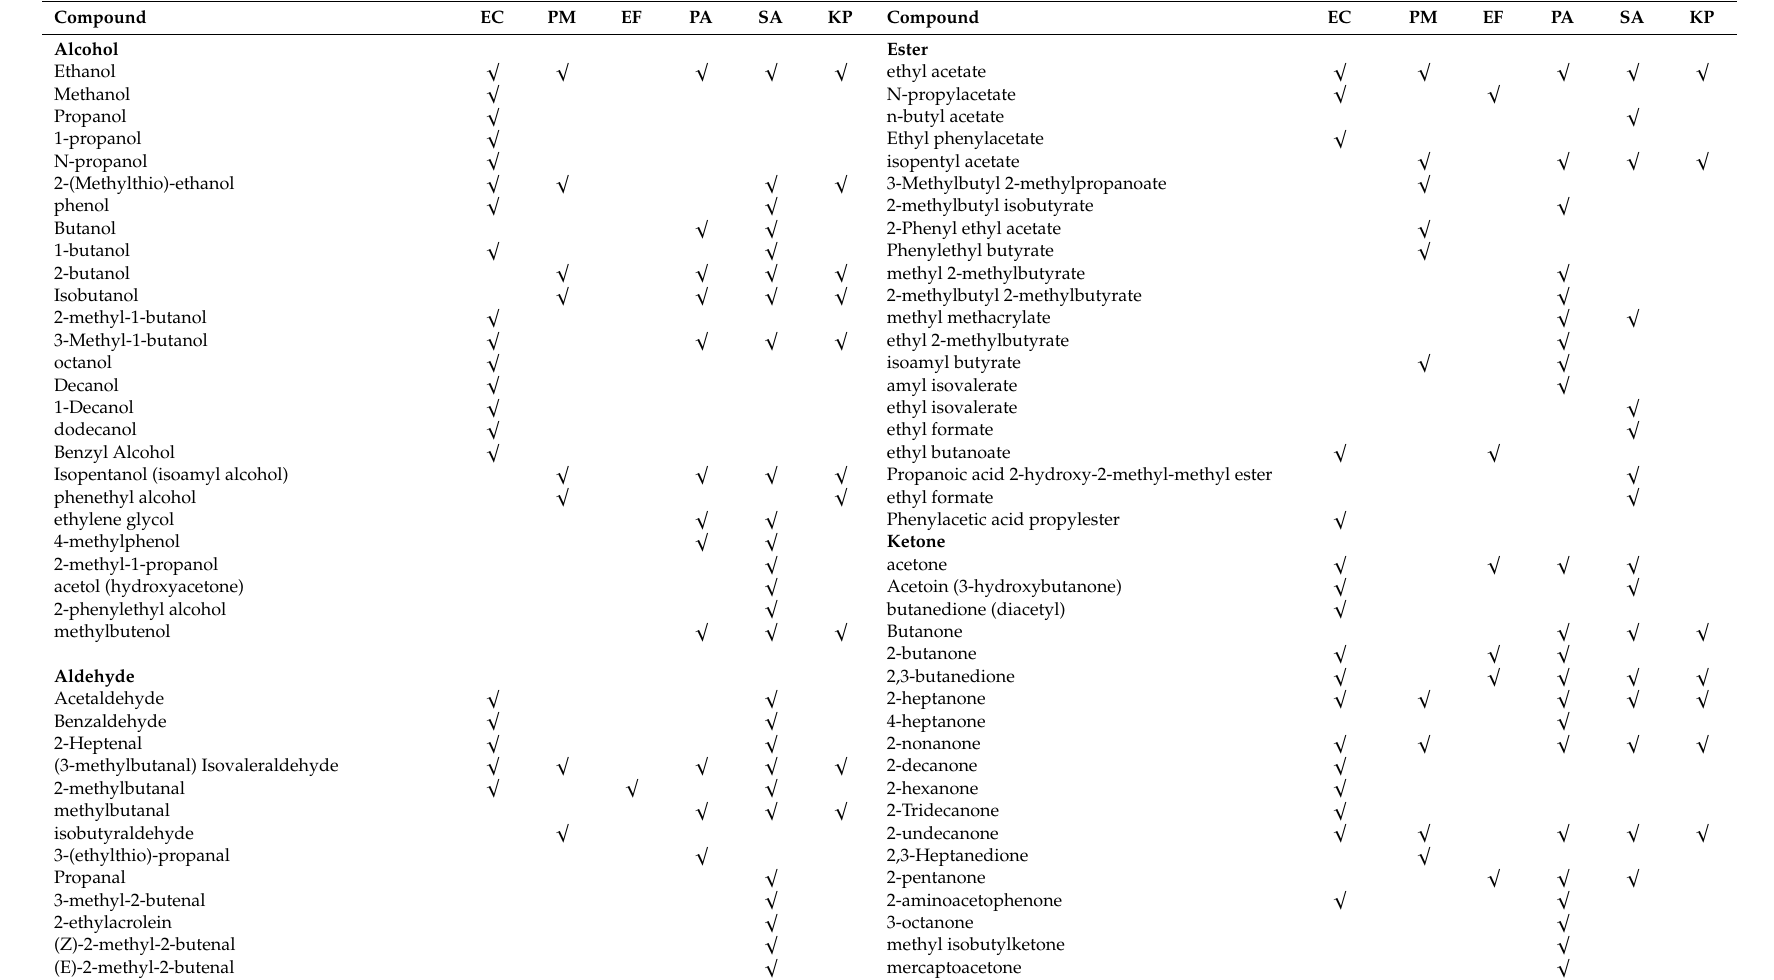
Table 2. Volatile Compounds of Di ff erent Urinary Tract Infection